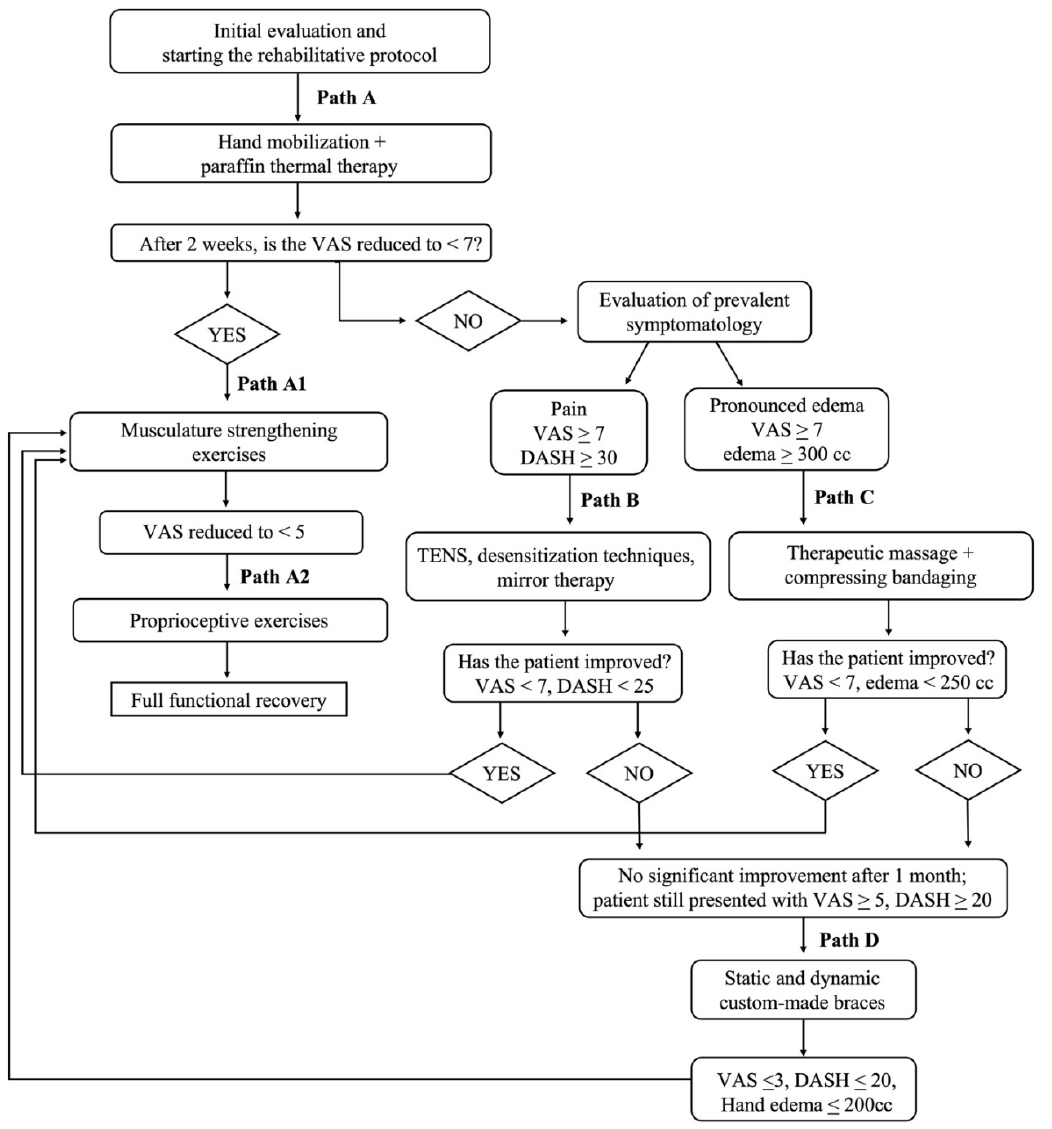
Figure 2. Flowchart to illustrate the decision tree rehabilitation protocol. Both the stages (paths) of the rehabilitation process and the criteria for the progression throughout the stages are reported.